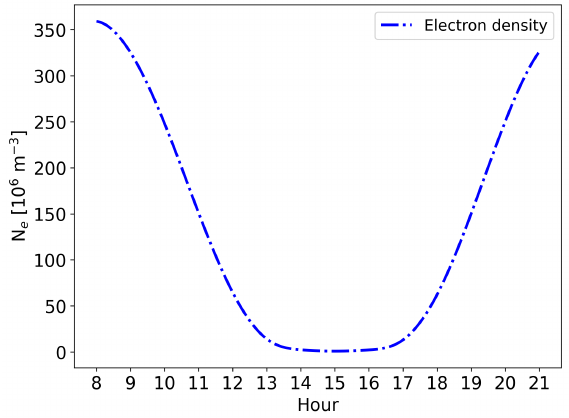
Figure 7. Monthly variation of electron number density N e at a height of 80 km.